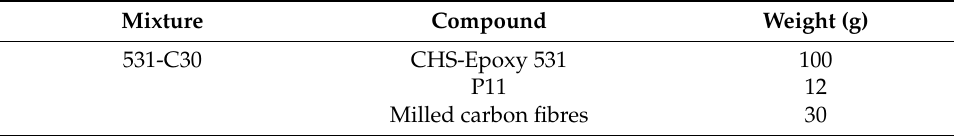
Table A8. Carbon fibres in CHS Epoxy 531, 30 phr